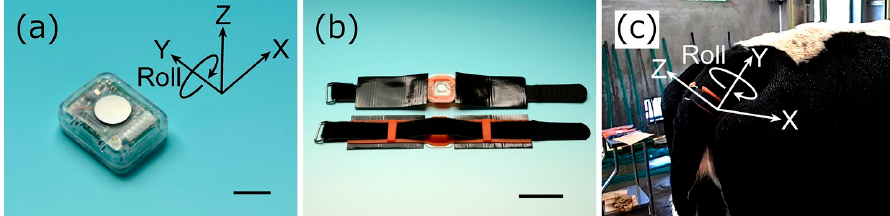
Figure 1. External appearance and usage of the multimodal tail-attached device (tail sensor). ( a ) External appearance of a tail sensor designed for fitting the ventral tail base of cattle. The sensor was attached so that the stainless steel plate for temperature measurement (the silver round part) was on the animal side. X, Y, and Z denote the axes of the 3-axis accelerometer. Roll indicates the rotation of the X- and Z-axes about the Y-axis. The sensor dimensions are 21.0 mm × 26.0 mm × 9.7 mm, and the sensor weight with the battery is 5.8 g. ( b ) Tail sensor in an attachment. The sensor was inserted into a pocket formed in a silicone rubber belt (orange part) and sealed with a urethane gel sheet. ( c ) Position of the tail sensor. The silicone rubber belt with the sensor was attached to the ventral tail base using double-sided adhesive tape, and its position was stabilized using a hook-and-loop fastener. The orientations of the X-, Y-, and Z-axes were lateral, proximal/distal, and dorsal/ventral to the tail, respectively. The bars in ( a , b ) are 1 cm and 5 cm, respectively. The tail sensor measured ST (in the range of 20 to 45 °C, with 0.05 °C resolution), ac-tivity intensity (in the range of 0 to 102.3, with 0.2 resolution), roll angle (rotation of the X- and Z- axes about the Y-axis: range of − 3 to +3 rad, with 0.05-rad resolution), and Y-axis acceleration (in the range of − 1000 to +1000 mg, with 4 mg resolution). The Y-axis acceler-ation has positive, zero, and negative values when the tail is down, horizontal, and raised above the horizontal, respectively. Therefore, hereinafter, Y-axis acceleration is referred as “tail raising index”. The sensor was attached to the pregnant cattle from 15.0 ± 4.6 days (n = 63) before the expected calving date until at least one day after calving. The sensor wirelessly transmit- ted the data to the receiver in real-time at 3-min intervals. The carrier frequency of the transceiver was 920 MHz, and the communication distance to the receiver was approxi- mately 100 m without obstacles. The data were uploaded to the cloud server via the Global System for Mobile Communication. The data were downloaded from the cloud server as comma-separated value files for the analysis.